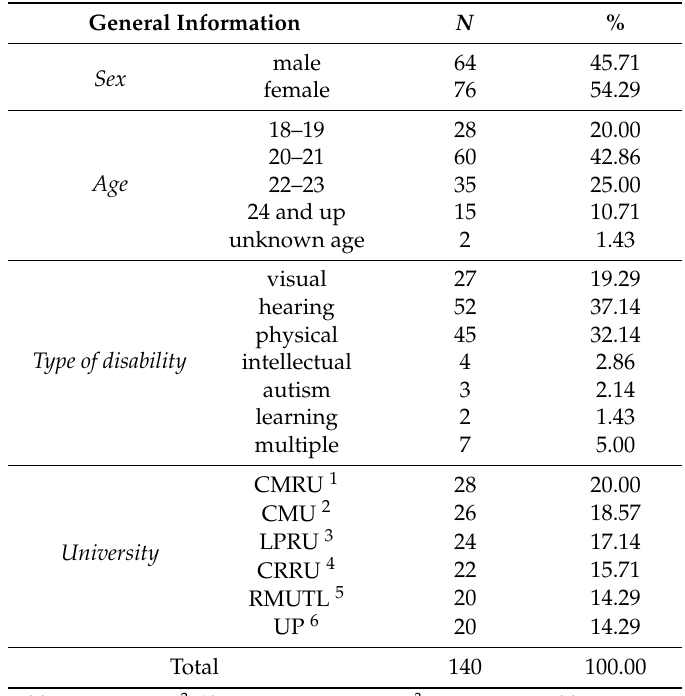
Table 1. Overview of students with disabilities in higher